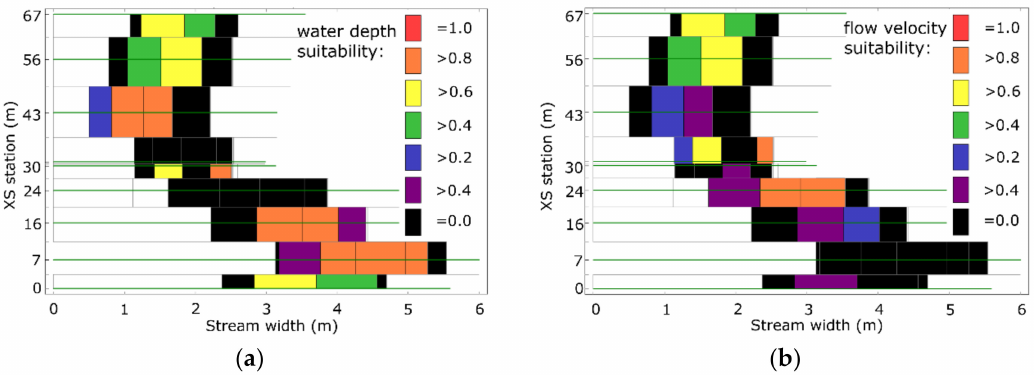
Figure 6. Comparison of the suitability for ( a ) water depth and ( b ) flow velocity for BT at the measured flow rate of Q = 0.12 m 3 · s − 1 in the Teplica